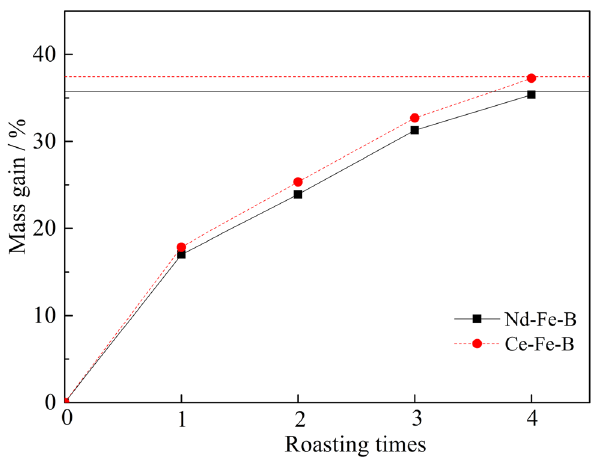
Figure 1: Mass gain curves of the Nd – Fe – B and Ce – Fe – B magnet scrap powders oxidized at 800°C for di ff erent